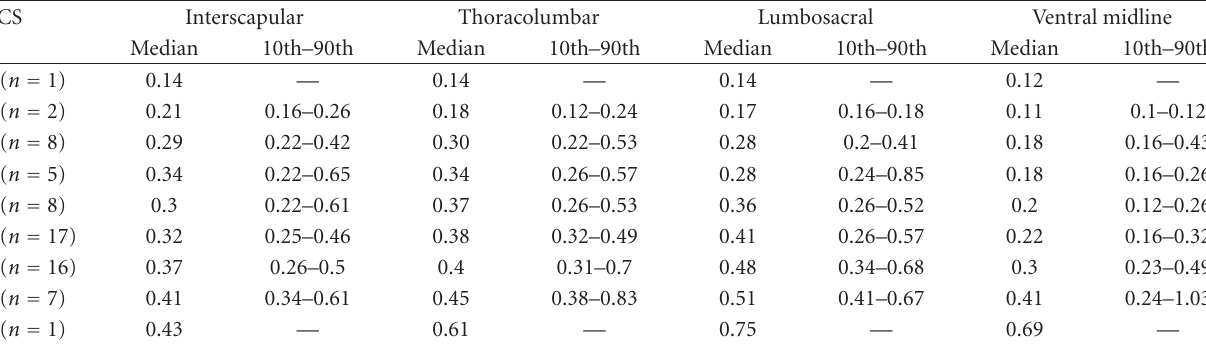
Table 2: Medians and 10th to 90th percentiles (in cm) for ultrasound fat depth measurements by site and body condition score category (BCS 1–9) (total n = 65).